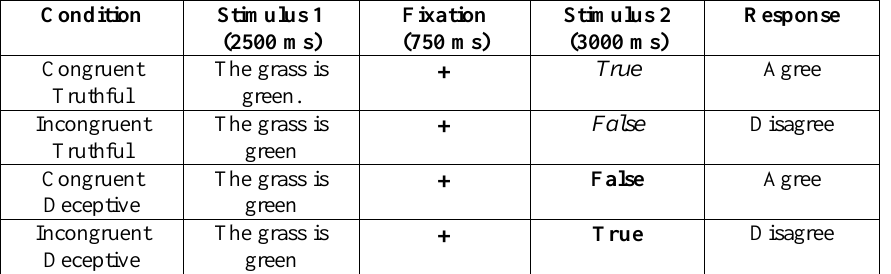
Note: In this example, the italicized text cues truthful responding, while the boldfaced text cues deceptive responding. A congruent response is one in which the participant indicates that Stimulus 2 is congruent with (i.e., “agrees” with) his or her answer for Stimulus 1 Fig. 6. Time course of stimulus administration for the two stimulus paradigm in Experiment